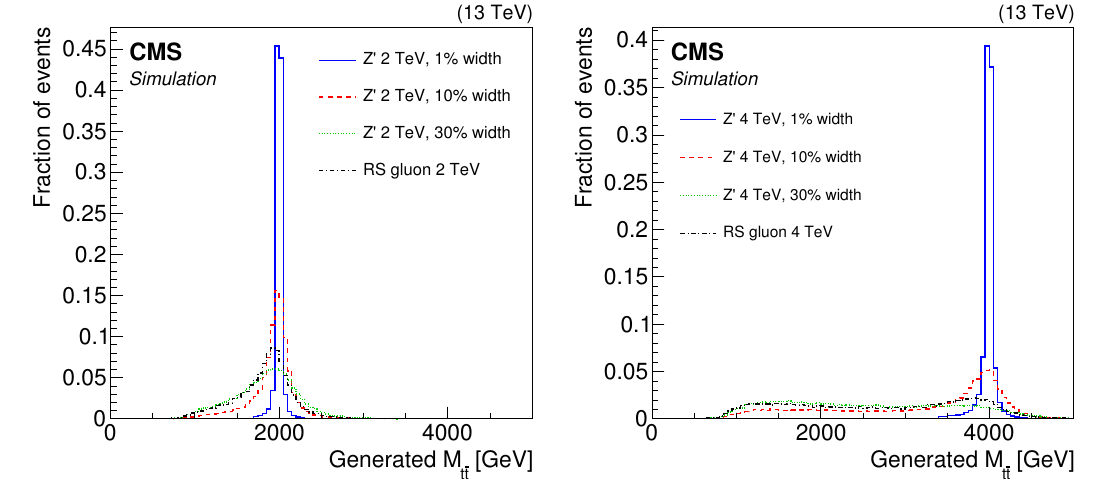
Figure 1 . Distributions of generator-level M for the production of new particles with masses of tt 2 TeV (left) and 4 TeV (right), for the four signal hypotheses considered in this analysis. The associated production of W or Z boson and jets is simulated using MadGraph